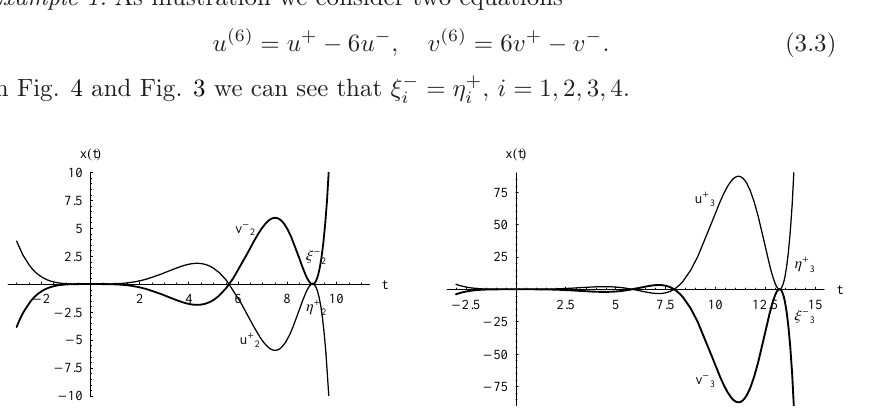
Figure 3. The extremal functions u +